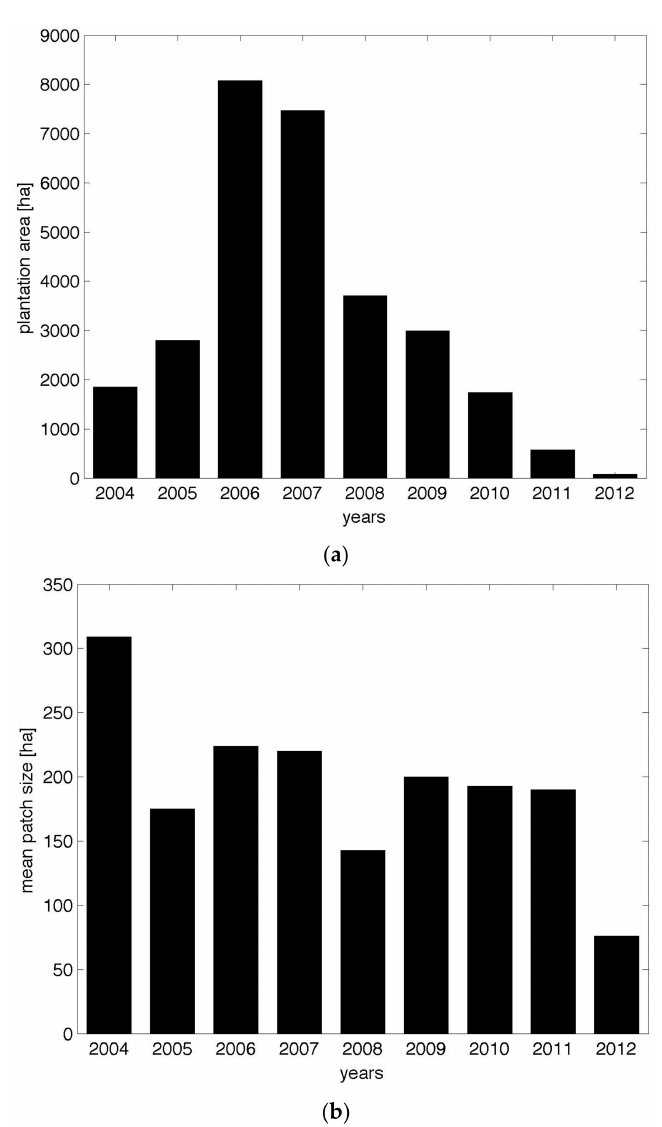
Figure 3. ( a ) Changes in rubber planted area between 2004 and 2012 in hectares. The areas correspond to what has been cleared/planted in individual years. ( b ) Changes in mean patch size of rubber planted area between 2004 and 2012 in hectares. The areas correspond to what has been cleared/planted in individual